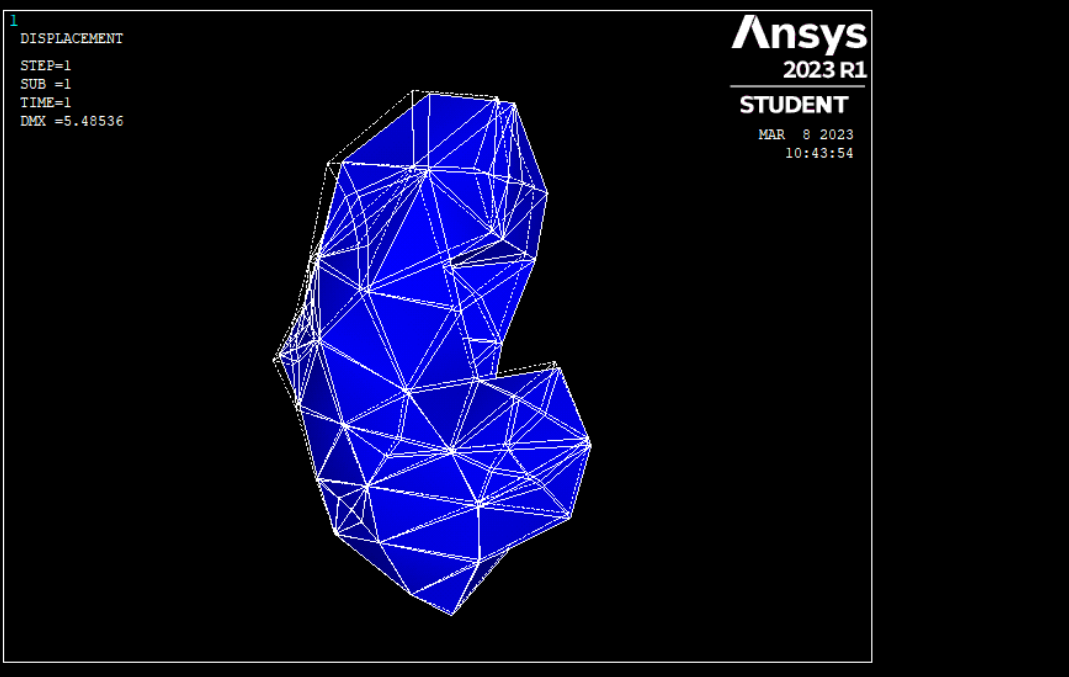
Figure 4. Undeformed and Deformed Geometry for Problem 1 (Nonlinear